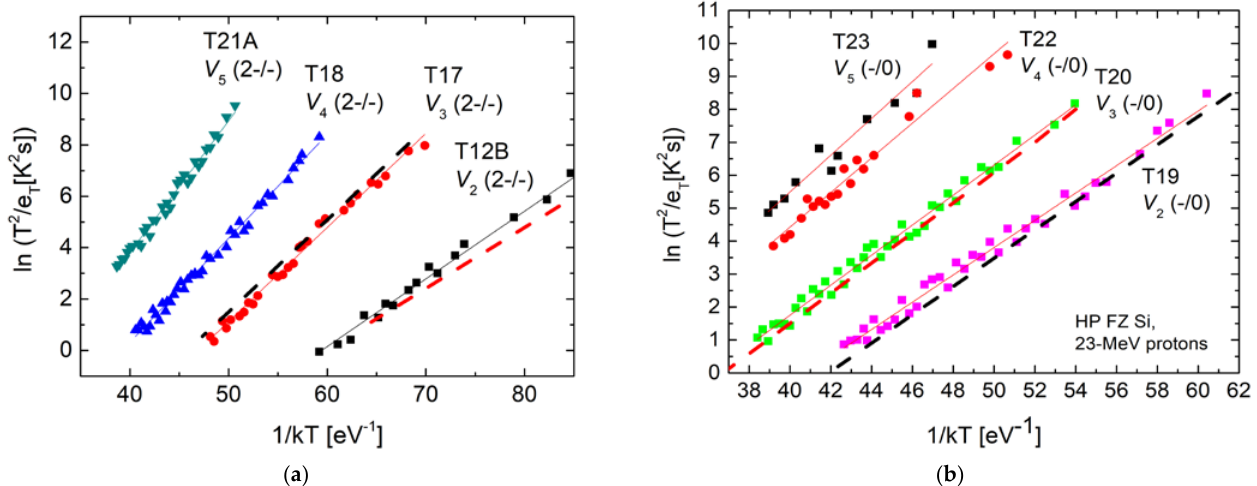
Figure 3. Arrhenius plots showing the temperature dependence of the thermal emission rate of charge carriers for the traps formed in HPSi under 23-MeV proton irradiation with fluences of 1 × 10 14 , 5 × 10 14 , 1 × 10 15 , and 5 × 10 15 n eq /cm 2 . ( a ) The Arrhenius plots for the T12B (black squares), T17 (red circles), T18 (blue triangles), and T21A (dark green inverted triangle) traps. The broken lines in red and black mark the Arrhenius plots reported for the V 2 (2− / −) and V 3 (2− / −) levels [7,9] for comparison with those for the T12B and T17 traps, respectively. ( b ) The Arrhenius plots for the T19 (magenta squares), T20 (light green squares), T22 (red circles), and T23 (black squares) traps. The broken lines in black and red mark the Arrhenius plots reported for the V 2 ( − /0) and V 3 ( − /0) levels [7,9] for comparison with those for the T19 and T20 traps, respectively.